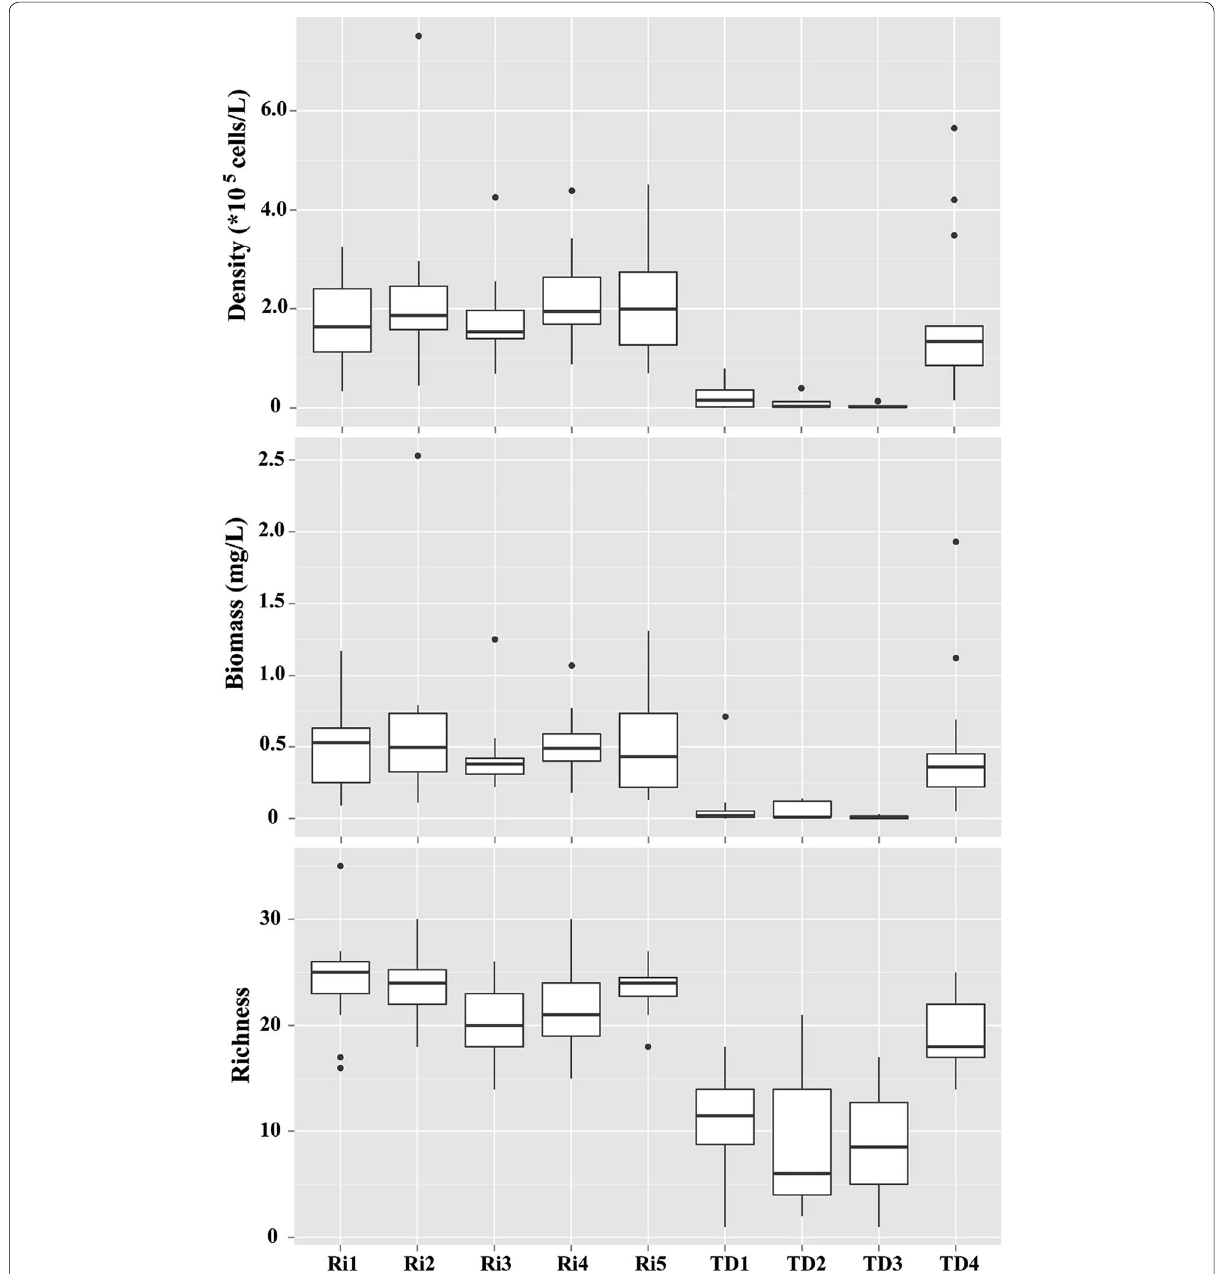
Fig. 3 Box plots of diatom density, biomass, and species richness at different sampling sites. Boxes show interquartile ranges (25th and 75th%), middle lines are medians, whiskers are non‑outlier ranges beyond the boxes, and dots are outliers. Other diversity indices performed similarly (not